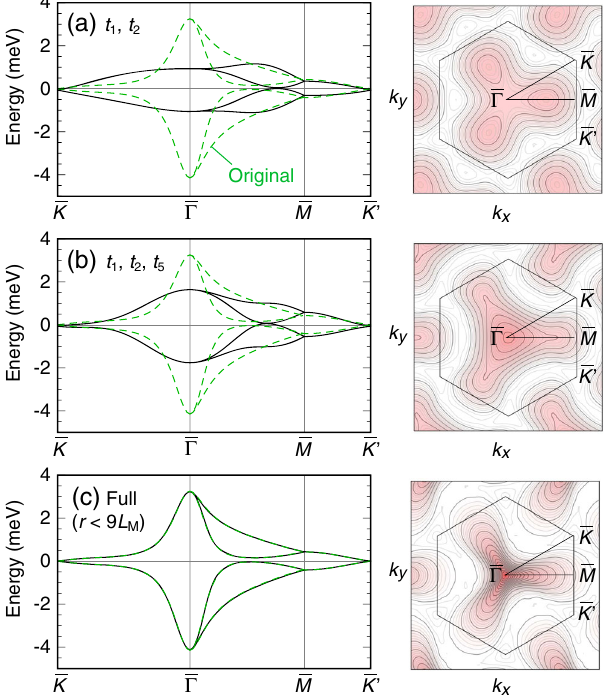
FIG. 5. Band structure in the effective tight-binding model for θ ¼ 1 . 05 °, with (a) t 1 and t 2 , (b) t 1 , t 2 , and t 5 , and (c) all the hopping parameters within the distance r < 9 L . The dashed M line indicates the original energy band of the effective continuum model. The right panels show the corresponding contour plots of E 1 ð k Þ for the valley ξ ¼ þ